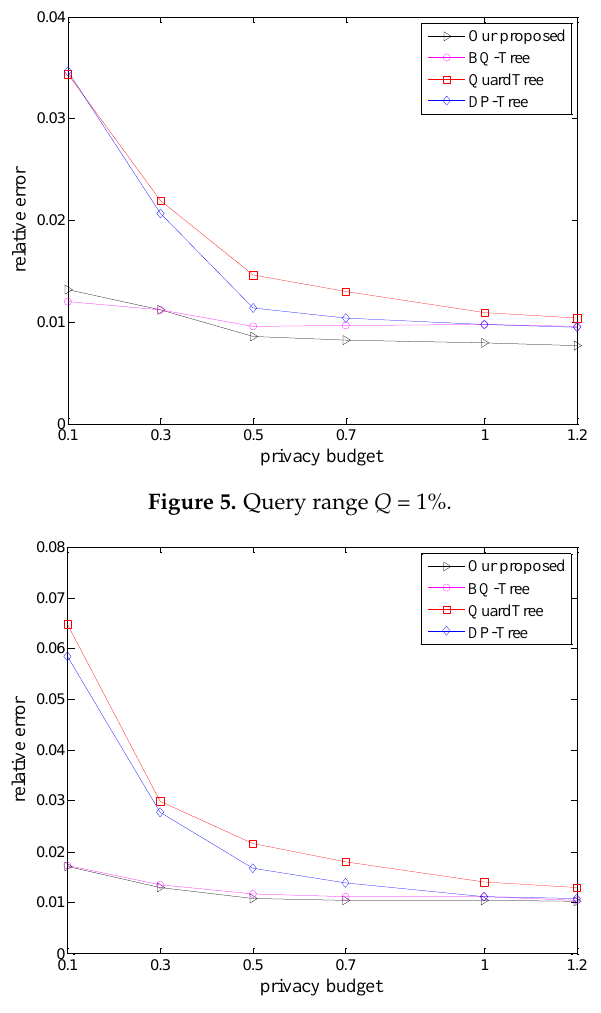
Figure 6. Query range Q = 5%.